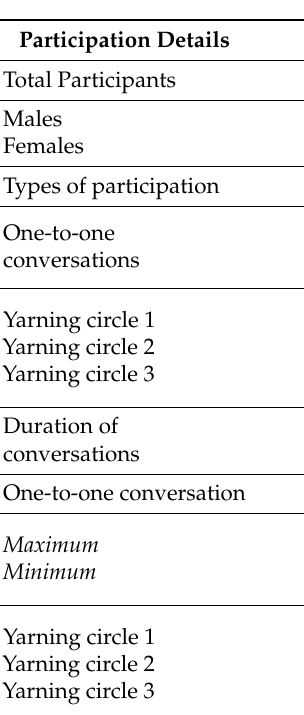
Table 1. Details of data collection and